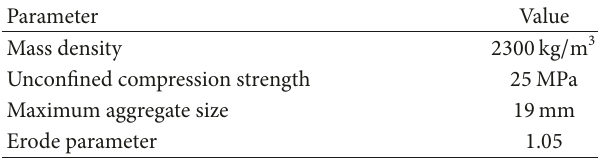
Table 2: Parameters for CSCM material model for